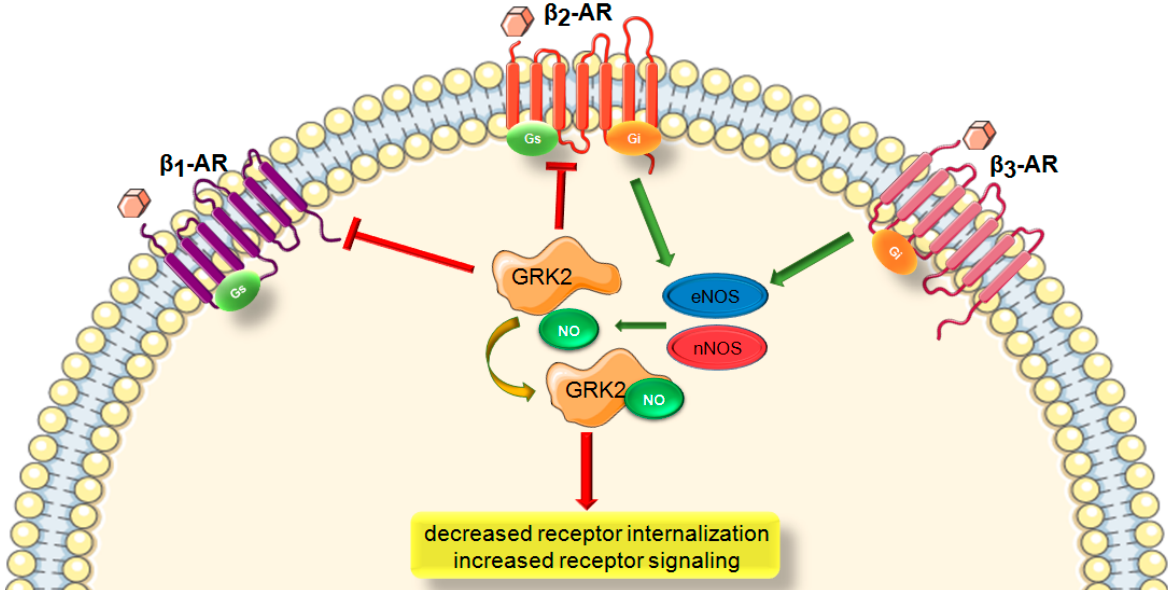
Figure 1. Schematic representation depicting the current understanding of the interaction between β -AR-signaling and GRK2 S-nitrosylation. β -AR, β -adrenergic receptor; G-protein subtypes (Gs or Gi); GRK2, G protein-coupled receptor kinase 2; NO, nitric oxide; eNOS, endothelial nitric oxide synthase; nNOS, neuronal nitric oxide synthase. Green arrow is used to indicate a stimulatory mechanism involved while red bar-headed line indicates an inhibitory mechanism.